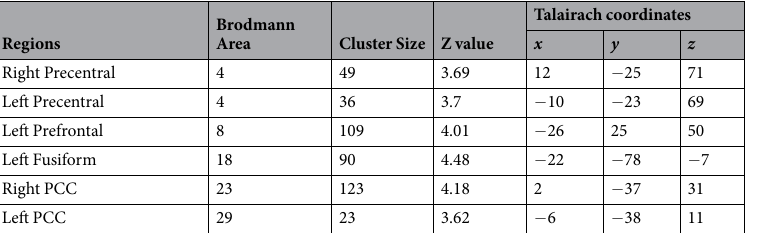
Table 3. Brain areas showing a higher BOLD signal in response to SS in the PI (n = 14) versus GS group (n = 18). Note: Z values refer to significant